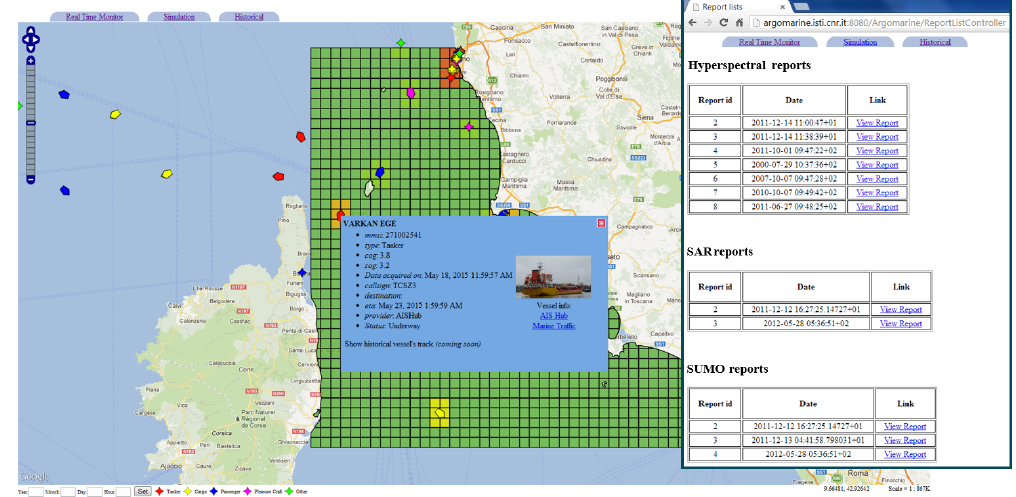
Figure 4. MIS interface showing the historic data selection available for visualization. (scale 1 cm:20